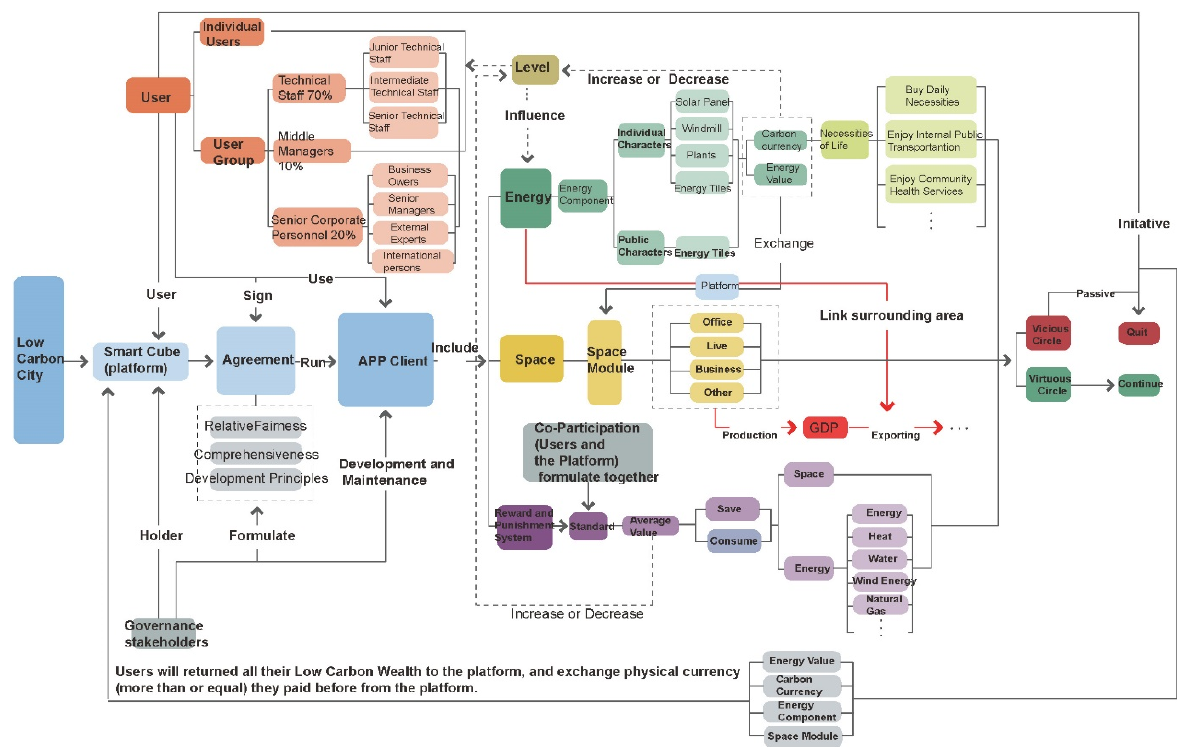
Figure 13. Schematic diagram for how the application platform supervises and operates the spontaneous growth of a community by information technology (Source: author).